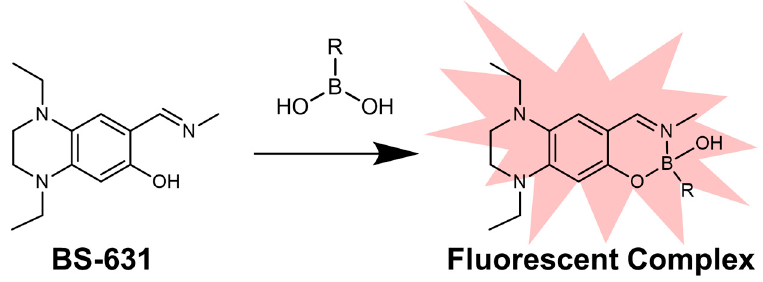
Figure 1. Schematic of boronic acid detection by fluorescent complex with BS-631.